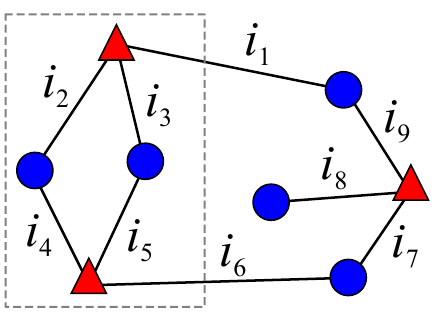
Figure 1: Representation of a CSP instance as a graph. Circles (triangles) represent variables (clauses). The dashed rectangle delineates the tensor contraction example discussed in the